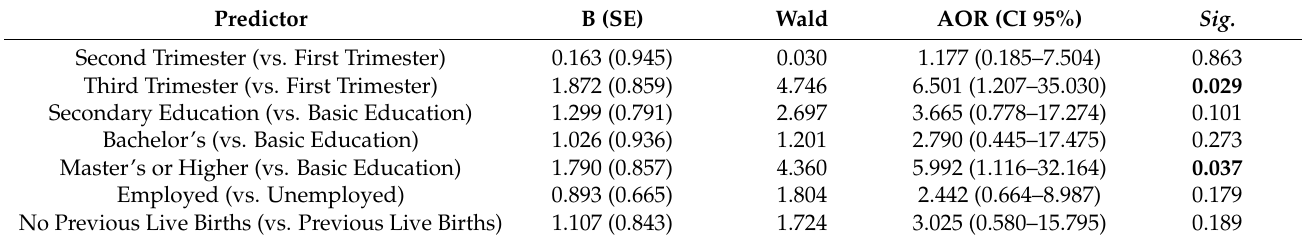
Table 9. Analysis of COVID-19 vaccine acceptance among pregnant women, University Hospital Brno, August–October 2021 ( n = 278).